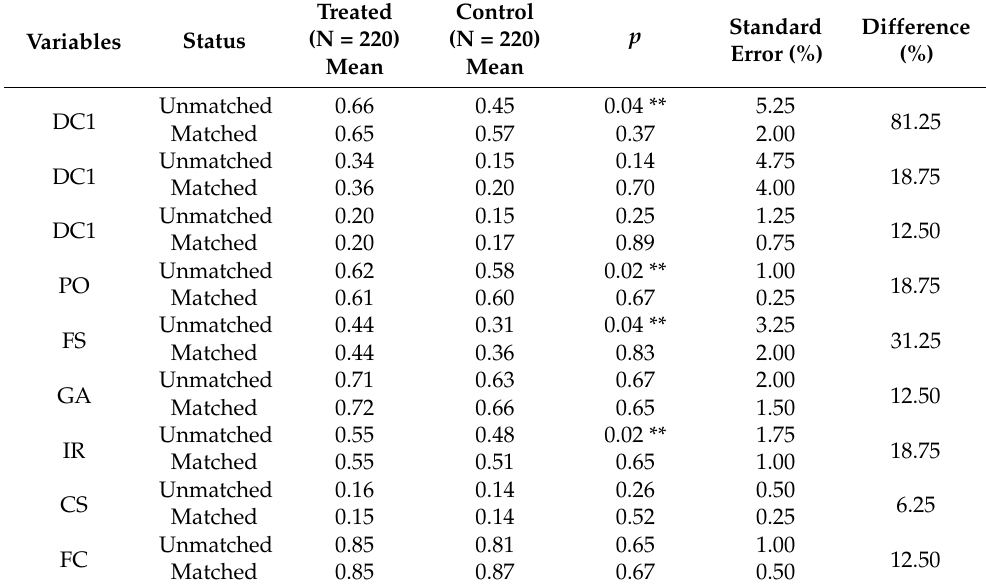
Figure 7. Residual analysis histogram with normal distribution. Table 8. The matching mass balance